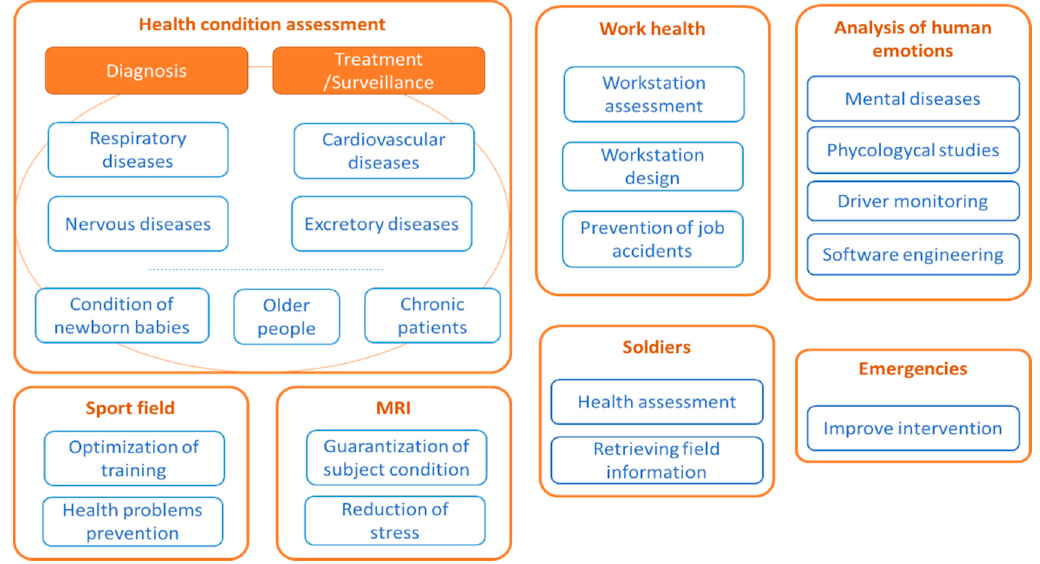
Figure 1. Most common application fields of sensing systems to monitor breathing.